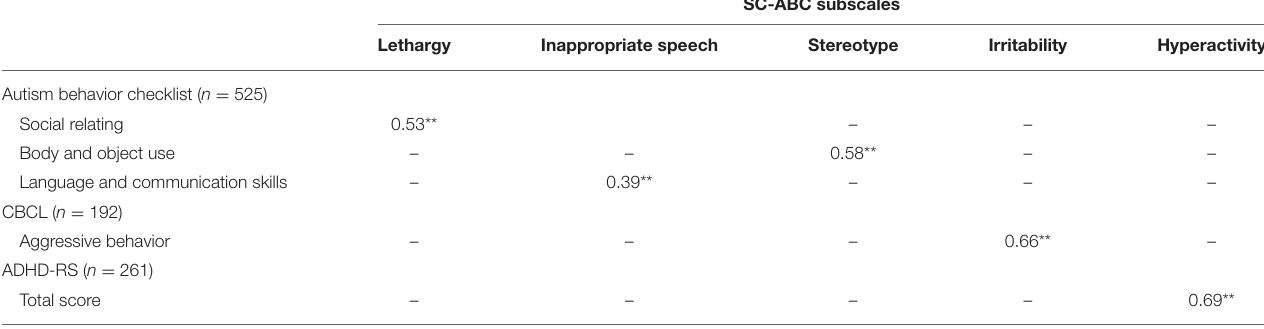
TABLE 4 | Spearman’s rank correlation coefficients for validity (age < 12).